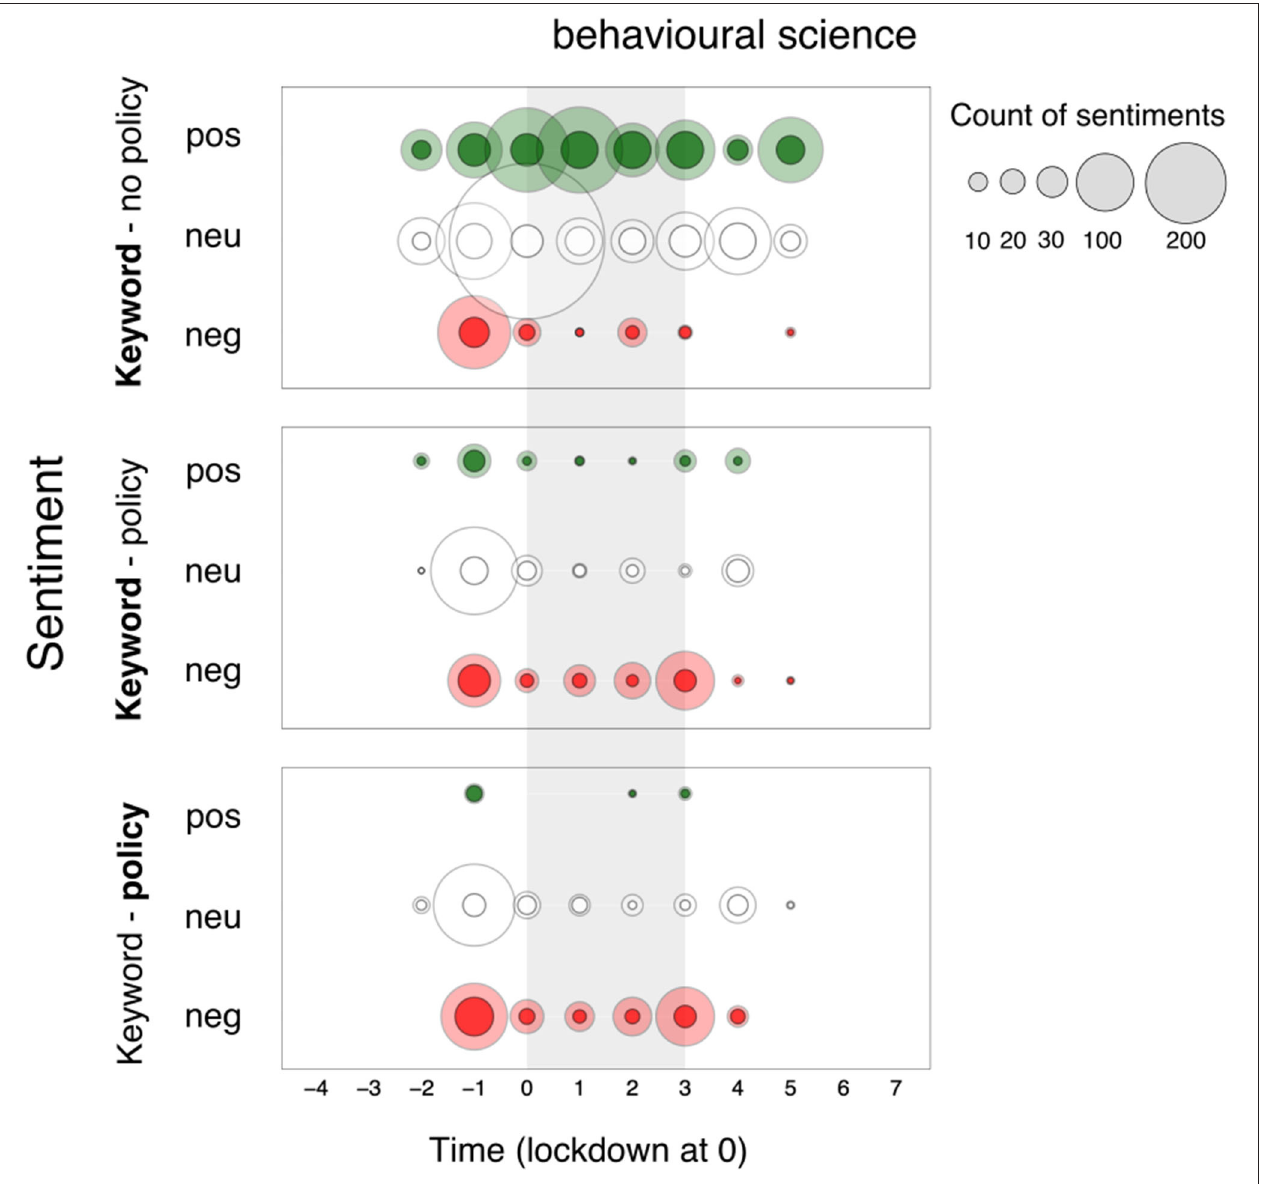
FIGURE 11 | Twitter articles - Sentiment toward “ Behavioural Science ” separated by sentences that do (top) and do not refer to policy application (middle), and sentiment toward policy contexts of keywords (bottom) over the 8 two-week time period surrounding the first British national lockdown of 2020. Sentiments are represented in counts of positive ( + 1 or + 2), neutral (0), and negative ( − 2 or − 1) bubbles over time, in green, white and red respectively. The area of the bubbles is proportional to the count of sentiments toward the keyword. Full-color bubbles represent sentiments in original tweets only; shaded-color bubbles represent sentiments accounting for